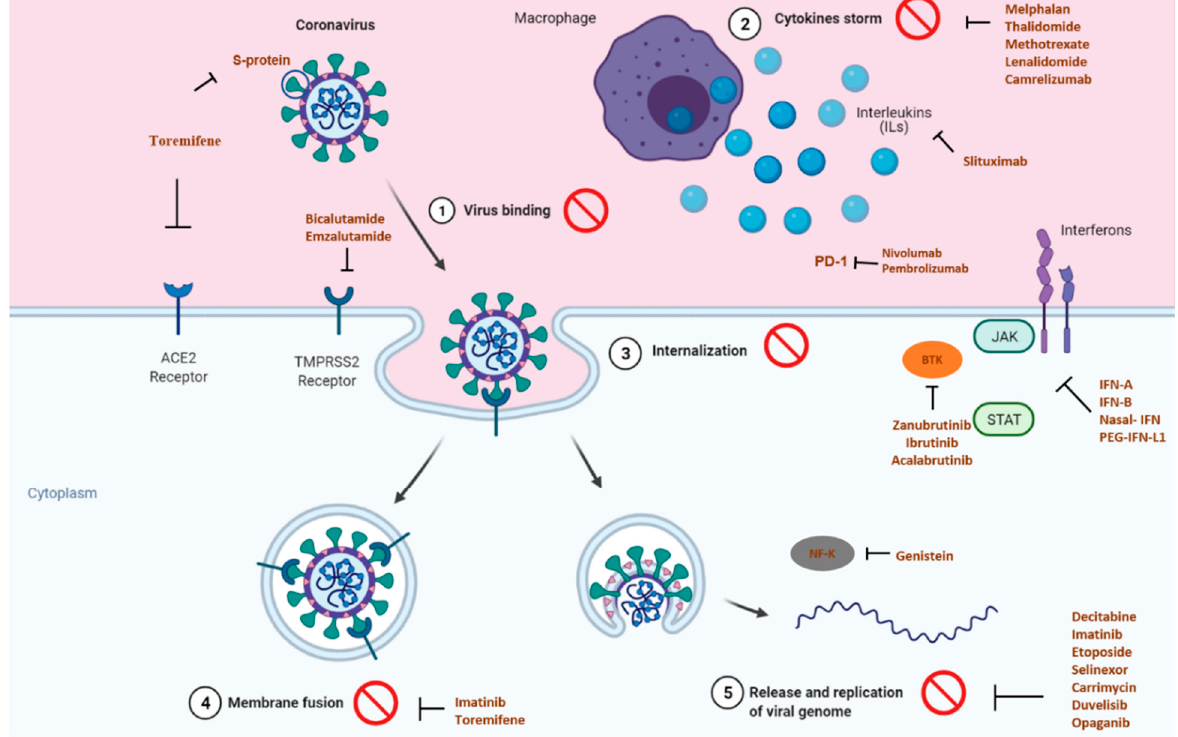
Figure 1. Principal targets of the anticancer drugs or drugs used for breast cancer supportive care, repurposed in clinical trials for COVID-19, adapted from BioRender templates [38].